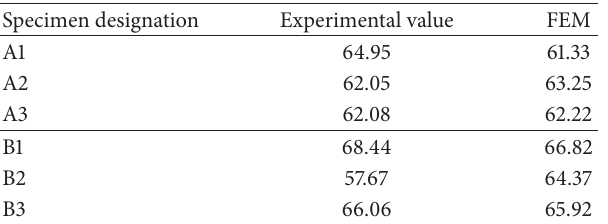
Table 2: The FEM and experimental results of unstable fracture energy 𝐺 𝑢 (N/m).